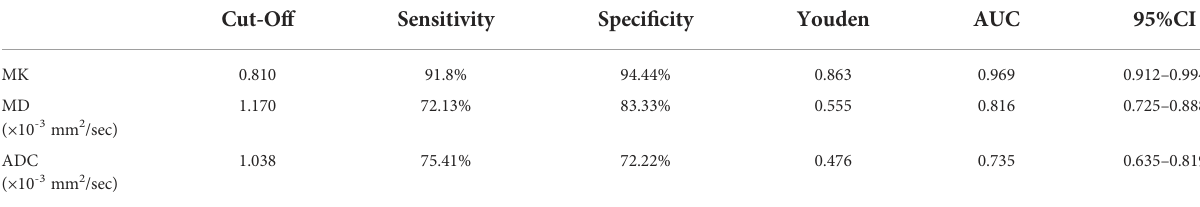
TABLE 2 Diagnostic ef fi cacy of MK, MD and ADC in identifying MVI.